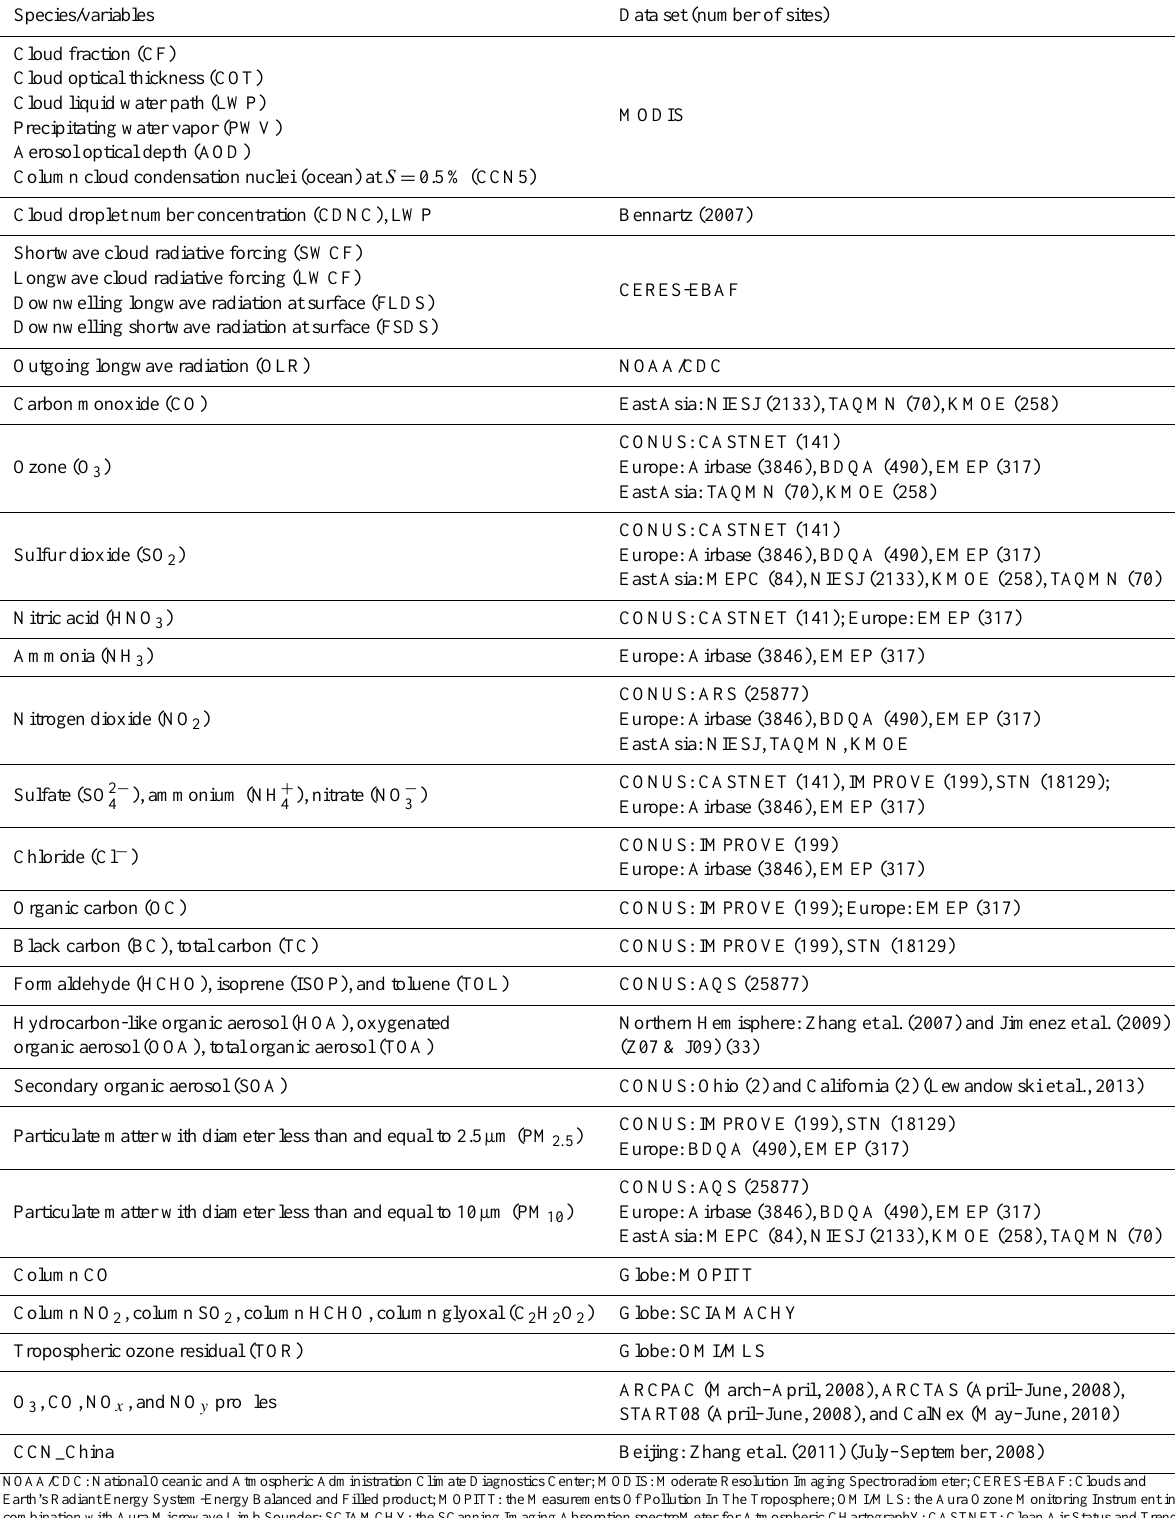
Table 2. Data sets for model evaluation. Species/variables Data set (number of sites) Cloud fraction (CF) MODISCloud optical thickness (COT) Cloud liquid water path